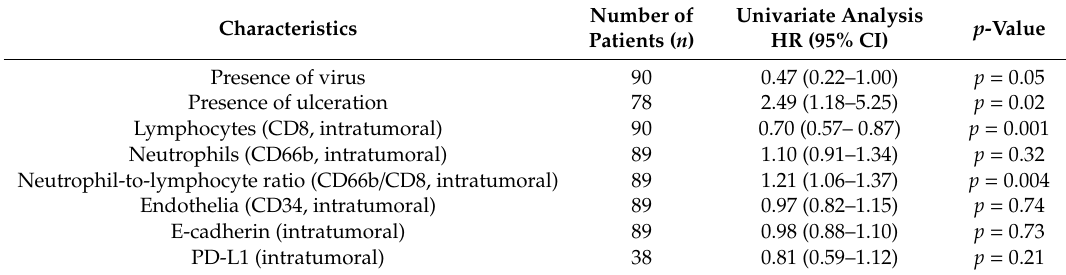
Table 2. Univariate analysis showing MCC-specific survival based on immune cells and biomarkers in the tumor microenvironment.